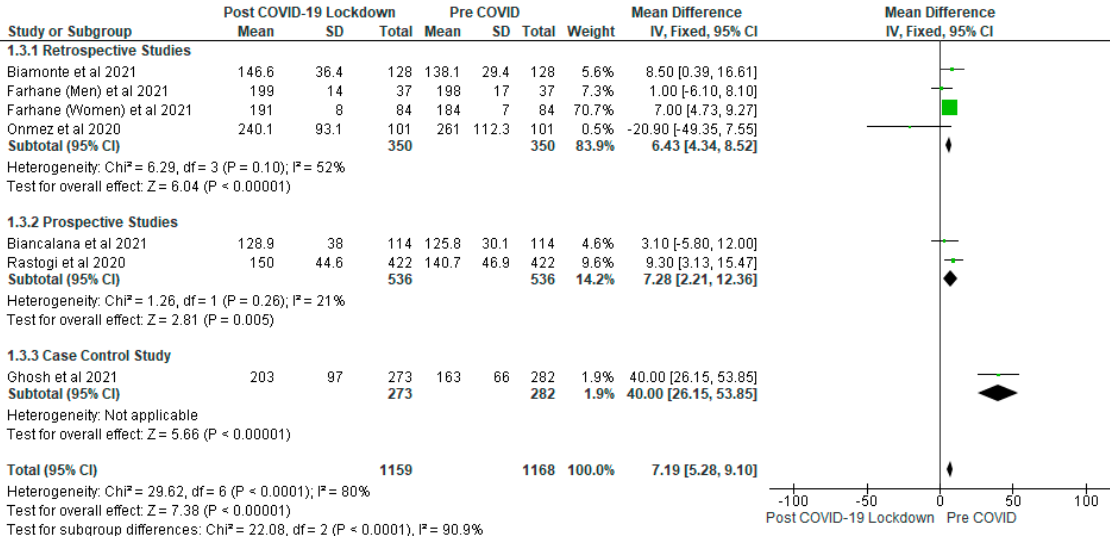
Figure 4. The effect of COVID-19 lockdown on Fasting Plasma Glucose